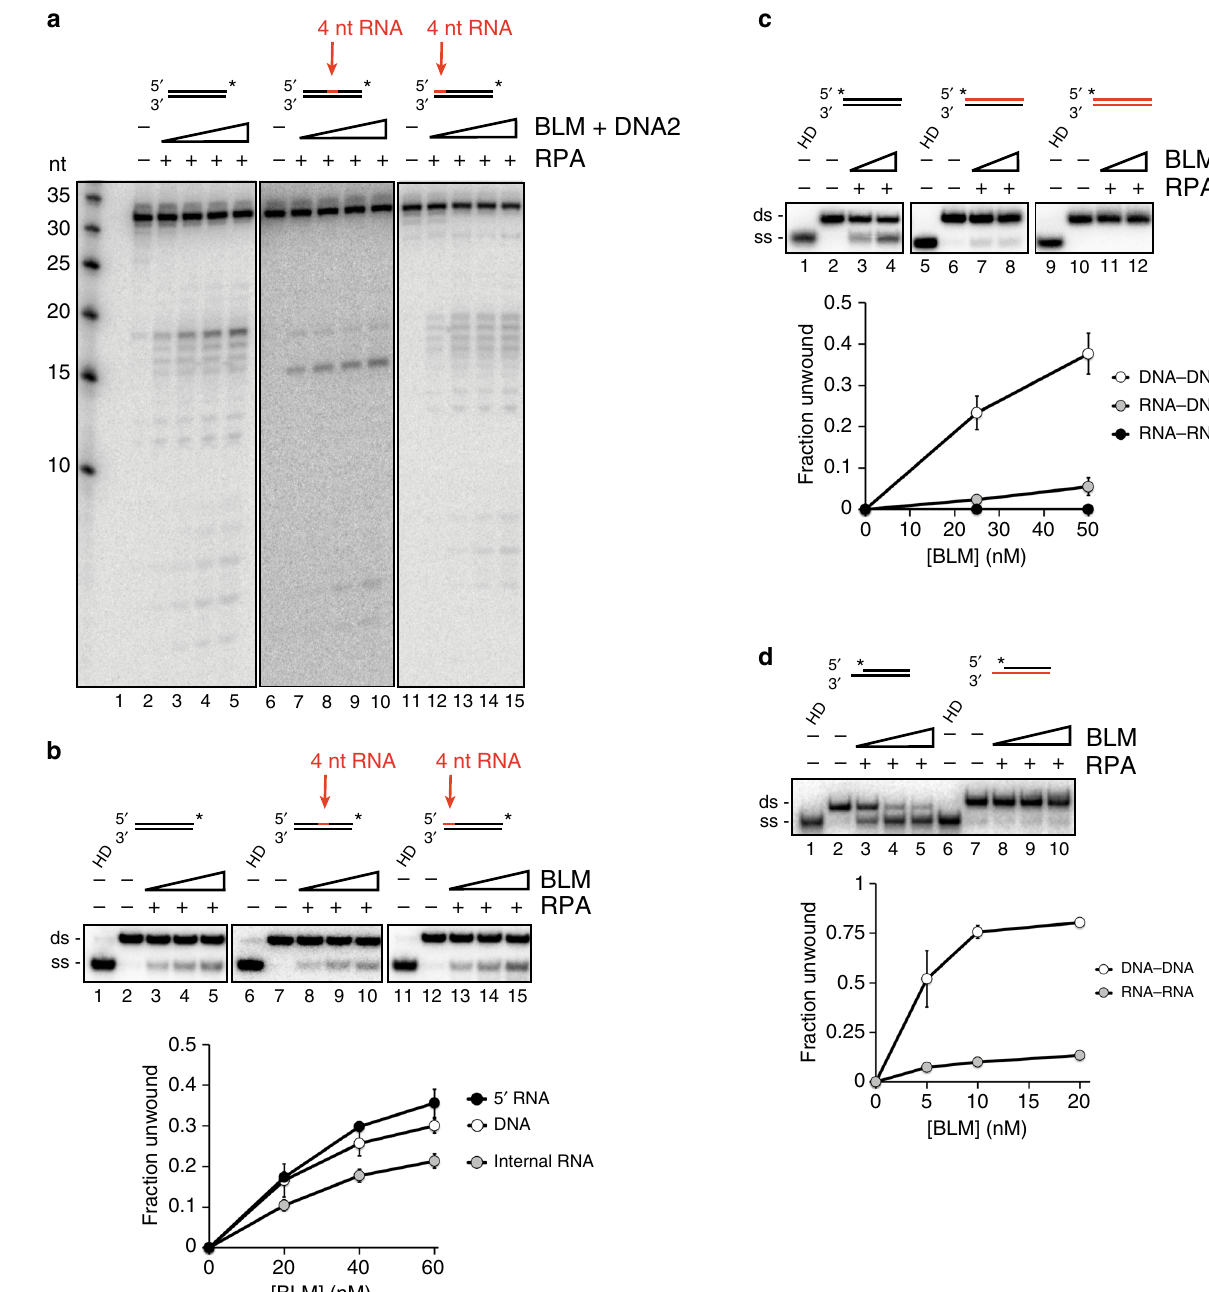
Fig. 3 Effect of ribonucleotides on resection by BLM-DNA2. a BLM and DNA2 (10, 20, 30, 40 nM) along with RPA (12.5 nM) were incubated with the indicated substrate (2.5 nM) at 37 °C for 10 min. Electrophoresis and quanti fi cation were performed as in Fig. 1a. b DNA unwinding by BLM (20, 40, 60 nM) was monitored in the presence of RPA (12.5 nM). Reaction mixtures were resolved in a 10% native acrylamide gel. In the lane labeled HD, the substrate was heat denatured by incubation at 95 °C for 2 min. The dsDNA and ssDNA bands were quanti fi ed and data were graphed. c Substrate unwinding by BLM (25, 50 nM) in the presence of RPA (12.5 nM) was examined as in ( b ). d Substrate unwinding by BLM (5, 10, 20 nM) was examined in the presence of RPA (12.5 nM) as in ( b ). Error bars in all the panels represent the standard deviation of results from n = 3 independent experiments, and all points represent the mean. RNA is denoted in red, and the asterisk indicates the location of the